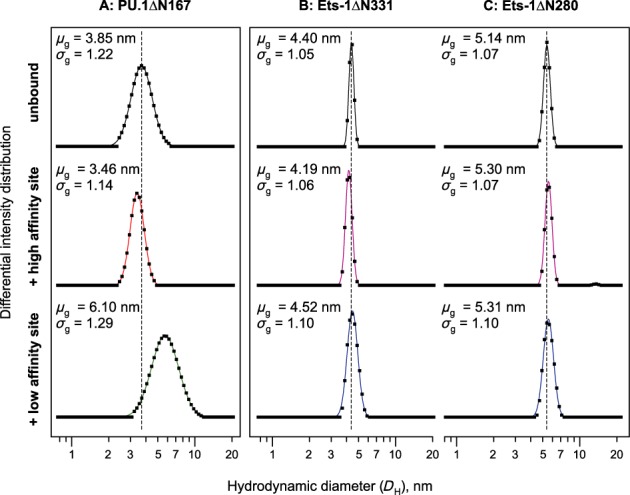
Heterogeneity in conformational dynamics of the homologous ETS domains of PU.1 and Ets-1 in unbound and DNA-bound states. Hydrodynamic diameter (DH) distributions of (A) PU.1ΔN167, (B) minimal Ets-1ΔN33, and (C) autoinhibited Ets-1ΔN280 in free solution with or without sequence-specific sites as measured by dynamic light scattering. The observed intensity distributions (symbols; integrated over 4 h) were fitted with log-normal distributions (lines). The least-square estimates for median hydrodynamic diameter (geometric mean, μg) and dimensionless geometric standard deviation (σg) are shown for each species; the standard error in each parameter is ±0.01 unit or lower. A range for DH is obtained by multiplying and dividing μg by σg. For each protein, the peak (modal) diameter for the unbound species is marked by a dashed line to guide the eye for comparison with the bound states.